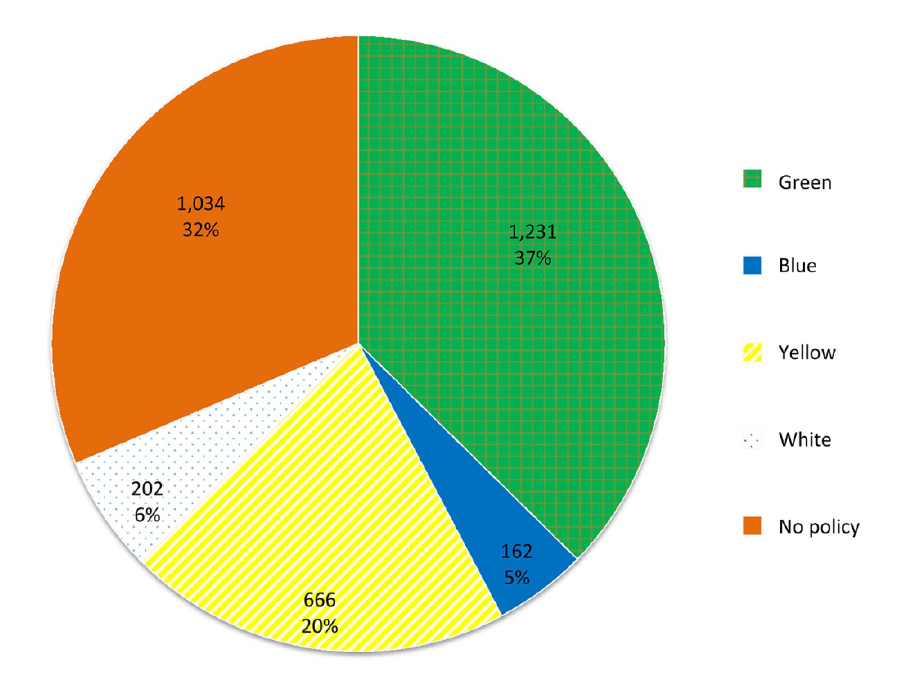
Figure 4 Sherpa/RoMEO archiving policies of Web of Science journals with publications by college of